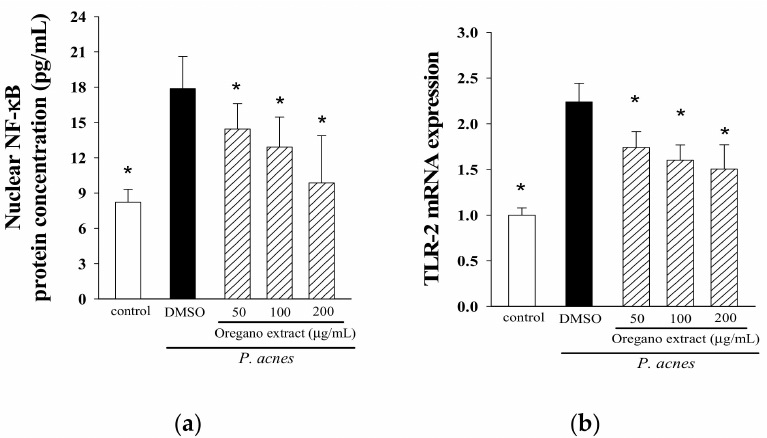
Figure 4. Effects of EOE supplementation on activation of nuclear factor kappa-B (NF- κ B) ( a ) and mRNA expression of toll-like receptor-2 (TLR2) ( b ). THP-1 cells were co-incubated with P. acnes and different concentrations (50, 100 or 200 µ g/mL) of EOE for 16 h. The TLR2 mRNA expression was normalized to glyceraldehydes 3-phosphate dehydrogenase (GAPDH) mRNA and expressed as multiples of change with the control. The bars indicate the mean ± SD of three independent experiments. The values with a symbol (*) are significantly different from the DMSO (vehicle) group at p <